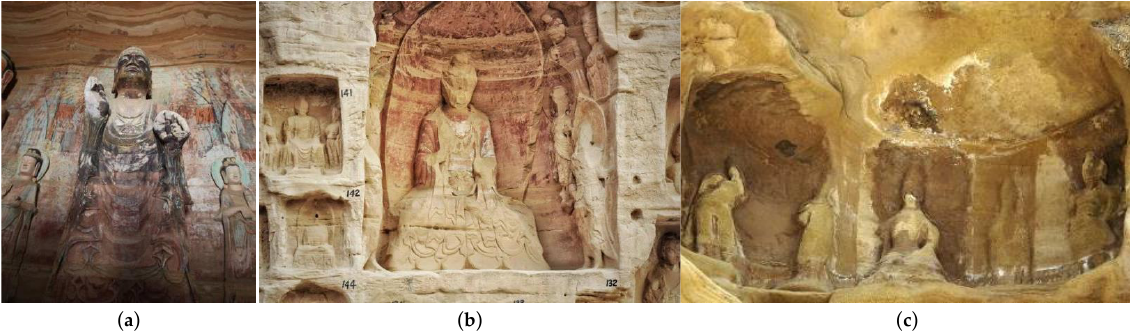
Figure 19. Schematic diagram of weathering in part of Qingyang North Grottoes. ( a ) Moderate weathering; ( b ) heavy weathering; ( c ) strong weathering. weathering; ( b ) heavy weathering; ( c ) strong